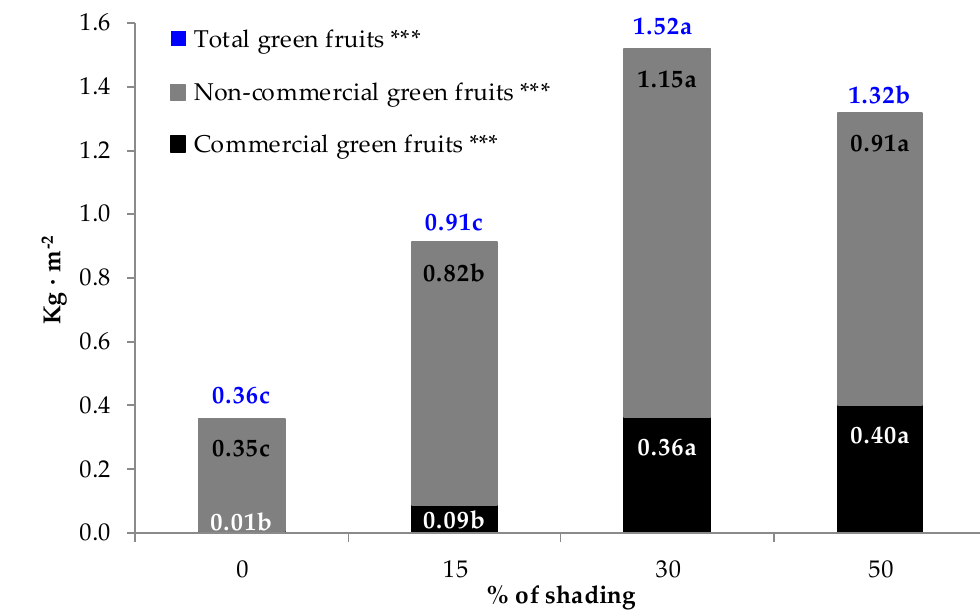
Figure 13. Shadow e ff ects on the green fruits yield (kg · m − 2 ; total, commercial and non-commercial) harvested in the last harvesting period (239 d.a.t). Results comes from the analysis of the variance that is performed according to the Yij model = µ + α i + β j + ε ij. The nomenclature n.s., *, ** and *** indicates not significant or significant for p ≤ 0.05, 0.01 and 0.001, respectively. Numerical values for each column followed by di ff erent letters denote statistical significance for p < 0.05 according to the corrected minimum significant di ff erences (LSD) test.